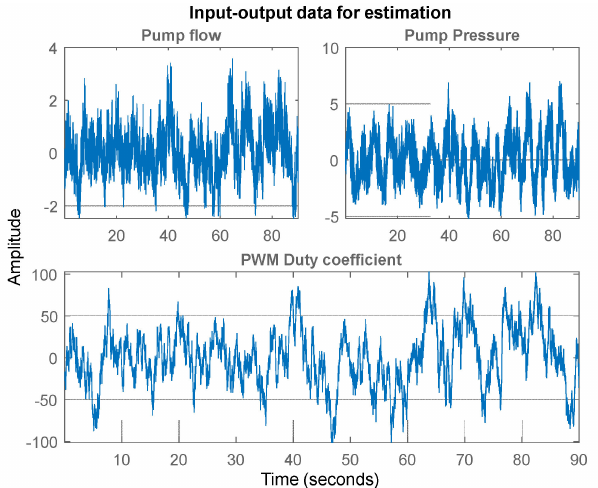
Figure 4. Pump flow rate, pressure, and control signal used for identification